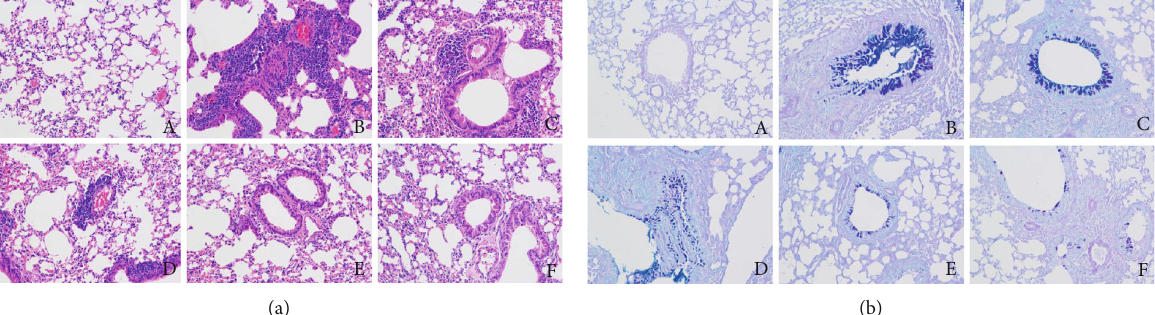
Figure 5: E ff ect of SCH on lung cell histology. (a) The lung tissues were combined to visualize the pathological condition using H&E staining. (b) Goblet cell hyperplasia in di ff erent groups was detected using AB-PAS staining. Magni fi cation, × 200. Group notations: A: control group; B: OVA group; C: OVA+SCH-L group; D: OVA+SCH-M group; E: OVA+SCH-H group; F: OVA+DXM